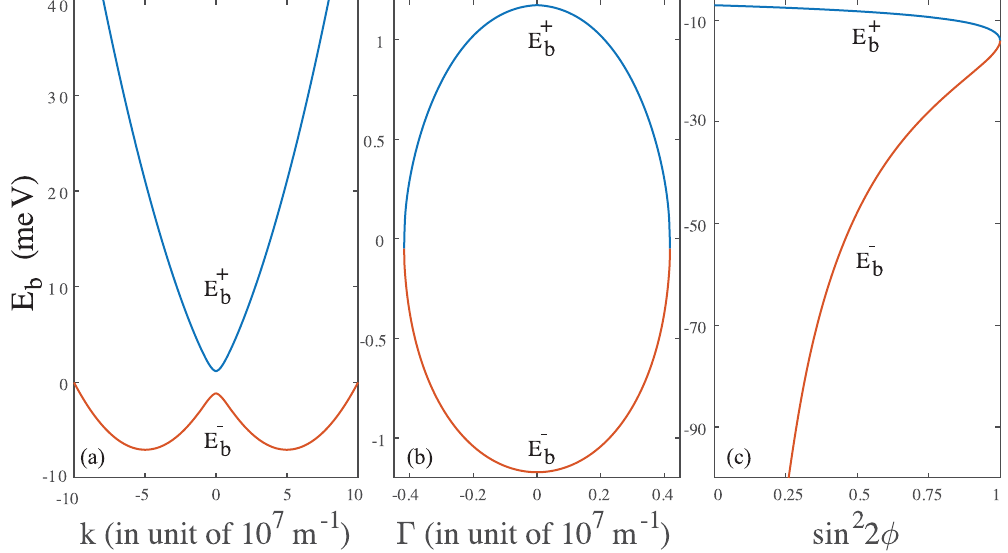
Figure 2. The bulk spectrum of the quantum dot with strong SOC α = 2.8 eV Å. ( a ) The bulk spectrum of plane-wave solution (7). ( b ) The bulk spectrum of exponential-function solution (8). ( c ) The bulk spectrum of combined plane-wave and exponential-function solution (12).